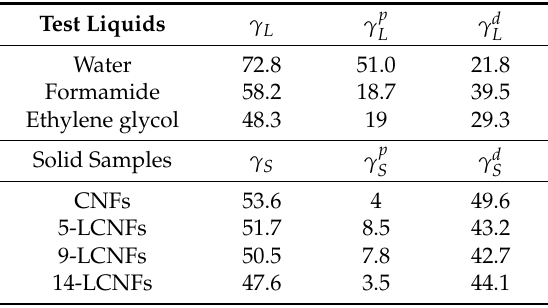
Figure 1. Properties of LCNFs with different lignin contents. ( A ) Dispersion in DMAc solution: (a) CNFs, (b) 5-LCNFs, (c) 9-LCNFs, and (d) 14-LCNFs; ( B ) TEM morphology: (a) CNFs, (b) 5-LCNFs, (c) 9-LCNFs, and (d) 14-LCNFs; ( C ) Thermal stability; ( D ) Contact angles for three different probing liquids. Table 1. Surface free energies of LCNFs with different lignin contents.